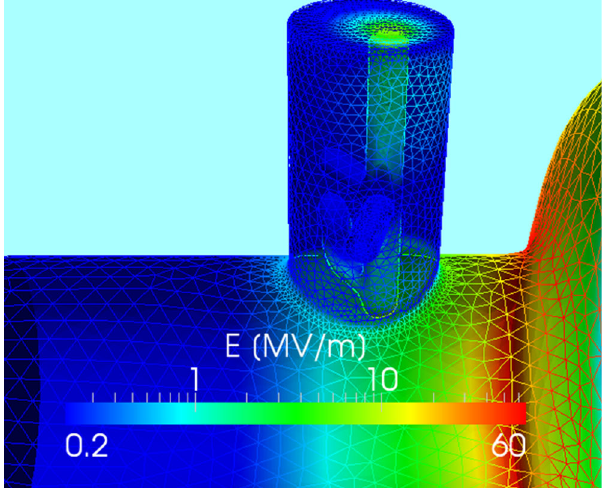
FIG. 4. Contour of the electric field in a TESLA-style HOM ¼ 31 . 5 MV = m). Rapid decay of the electric field of coupler ( E acc the fundamental mode from the end cell (at right) into the beam tube (at left) is evident. The peak local electric field at the tip of the coupling loop is 27% of the accelerating gradient. The peak electric field across the gap (gap 1 in Fig. 1) between the antenna and the bottom of the HOM can is 19% of the accelerating